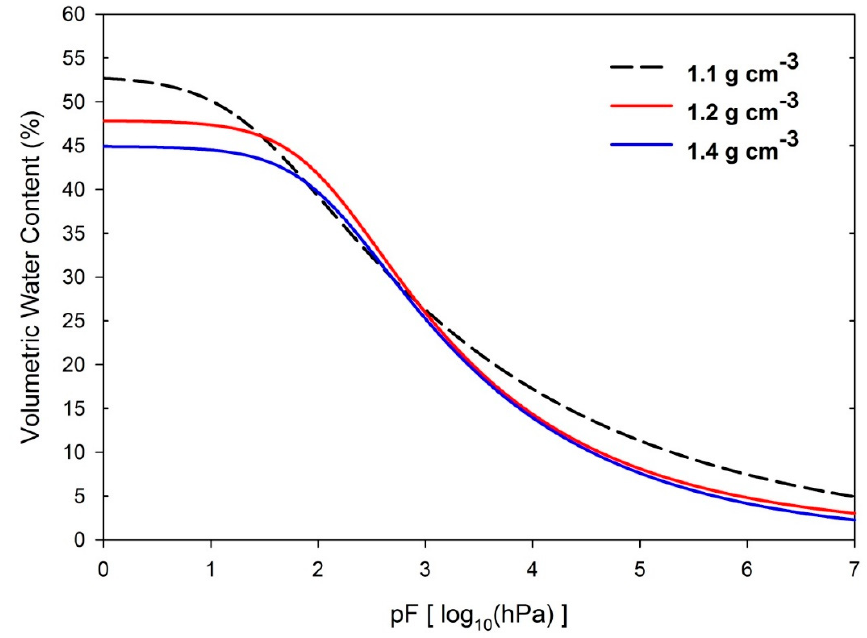
Figure 1. Averaged water retention curves combined from the Black Chernozem and Dark Grey Luvisol soils assembled by bulk densities of (i) 1.1 g cm − 3 , (ii) 1.2 g cm − 3 , and (iii) 1.4 g cm − 3 . These modelled curves were created from tensiometer measurements in undisturbed soil core samples ( n = 96) taken at a depth increment of 5–15 cm that were categorized for each of the dry bulk density treatments in our study by encompassing data within a range of ± 0.05 g cm − 3 . The bulk density of 1.1 g cm − 3 corresponds to a control treatment, 1.2 g cm − 3 represents un-trafficked field areas, and 1.4 g cm − 3 symbolizes tramlines or intensively trafficked field areas. The modelled water retention curves indicate that our experimental volumetric water contents of 33% and 41% corresponds to near − 350 hPa (pF = 2.5) and − 100 hPa (pF = 2.0), respectively, across the various bulk density categories. pF corresponds to log10 of water potential (hPa)